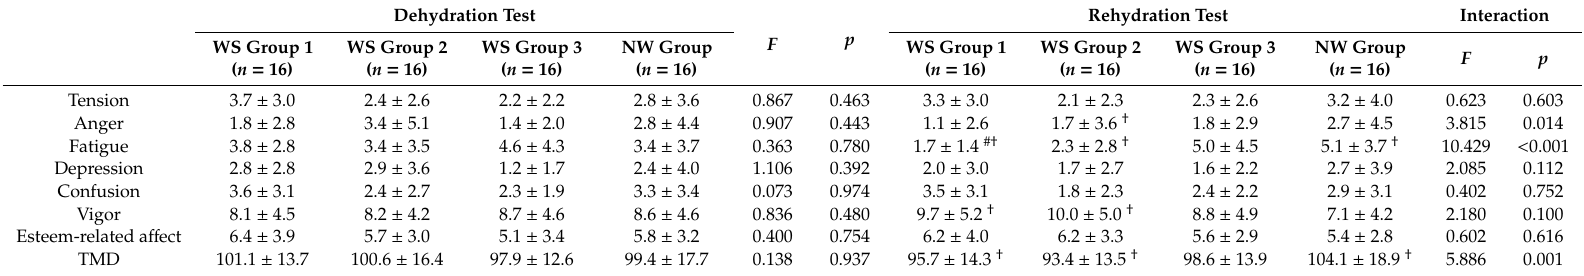
Table 3. The POMS of participants.